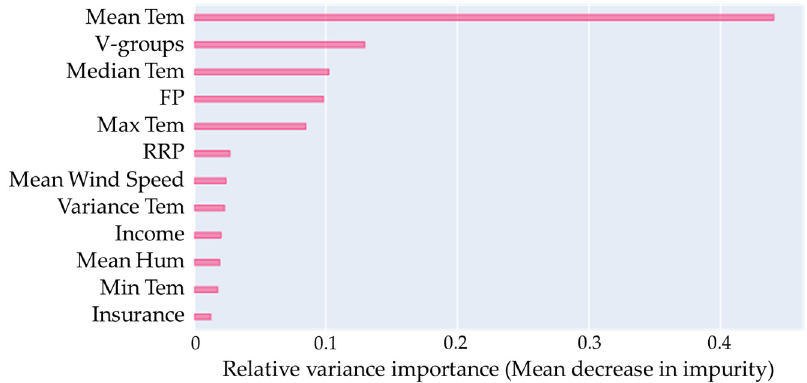
Figure 5. Variance importance in the RF model.